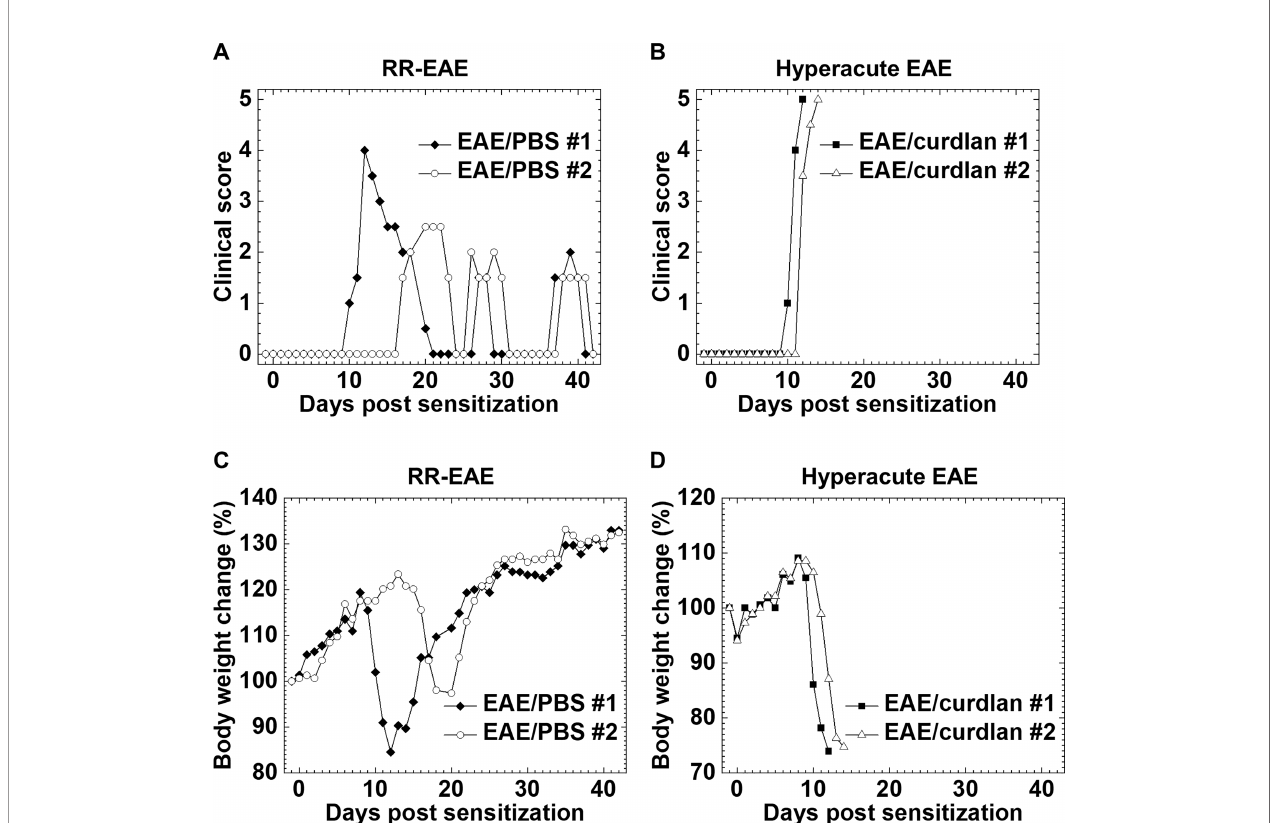
FIGURE 1 | Two clinical courses of experimental autoimmune encephalomyelitis (EAE) induced with myelin proteolipid protein (PLP) 139-151 . One day prior to EAE induction, SJL/J mice were injected intraperitoneally (i.p.) with phosphate-buffered saline (PBS) (EAE/PBS, A, C ) or curdlan (EAE/curdlan, B, D ). Mice were observed for clinical signs (A, B) and weight changes (C, D) for 6 weeks. In the EAE/PBS group, mice developed relapsing-remitting (RR)-EAE; the mice had hind limb paralysis around 2 weeks post sensitization, recovered within 10 days (remission), and had relapses once or twice during the 6-week observation period. In the EAE/ curdlan group, mice develop hyperacute EAE; the mice had progressive motor paralysis without remission and died within 1 week following the disease onset. Results are the two representative mice of 12 mice per group from three independent